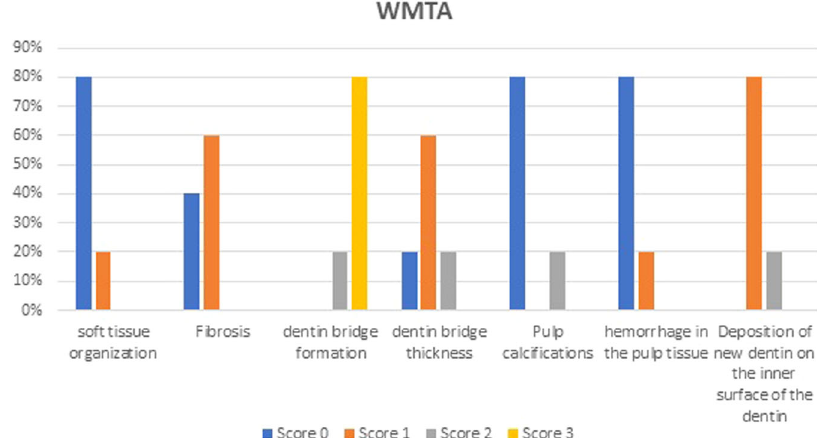
Fig. 6 The average percentage of histopathological pulp response to WMTA.